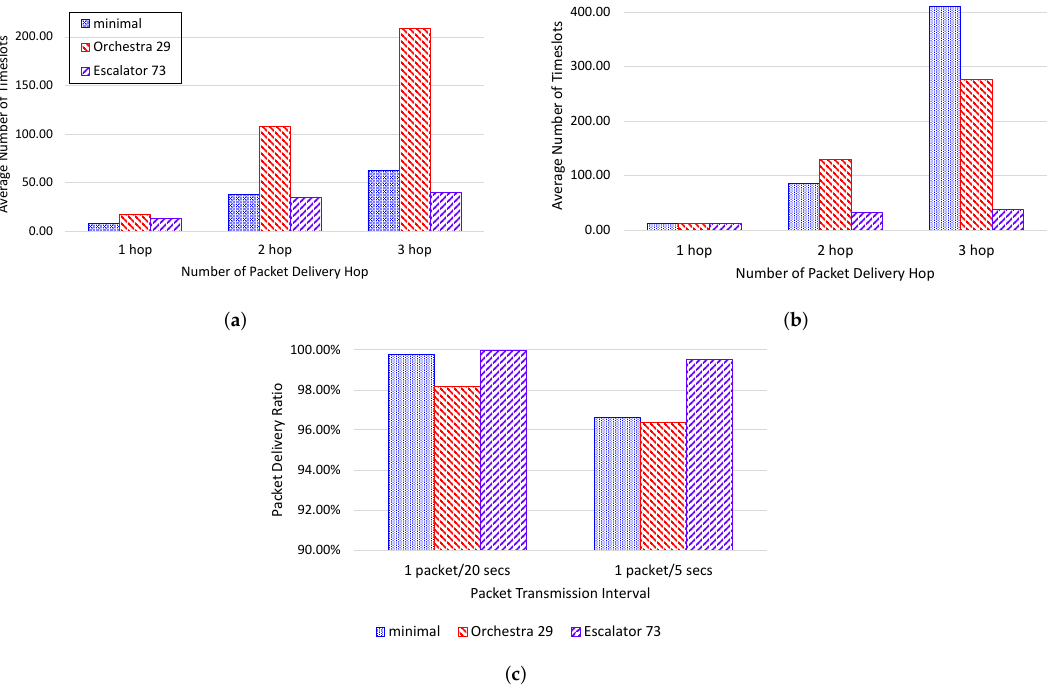
Figure 10. Testbed results: ( a ) end-to-end delay by packet transmission hop when the packet transmission interval is 20 s; ( b ) end-to-end delay by packet transmission hop when the packet transmission interval is 5 s; ( c ) PDR per the packet transmission